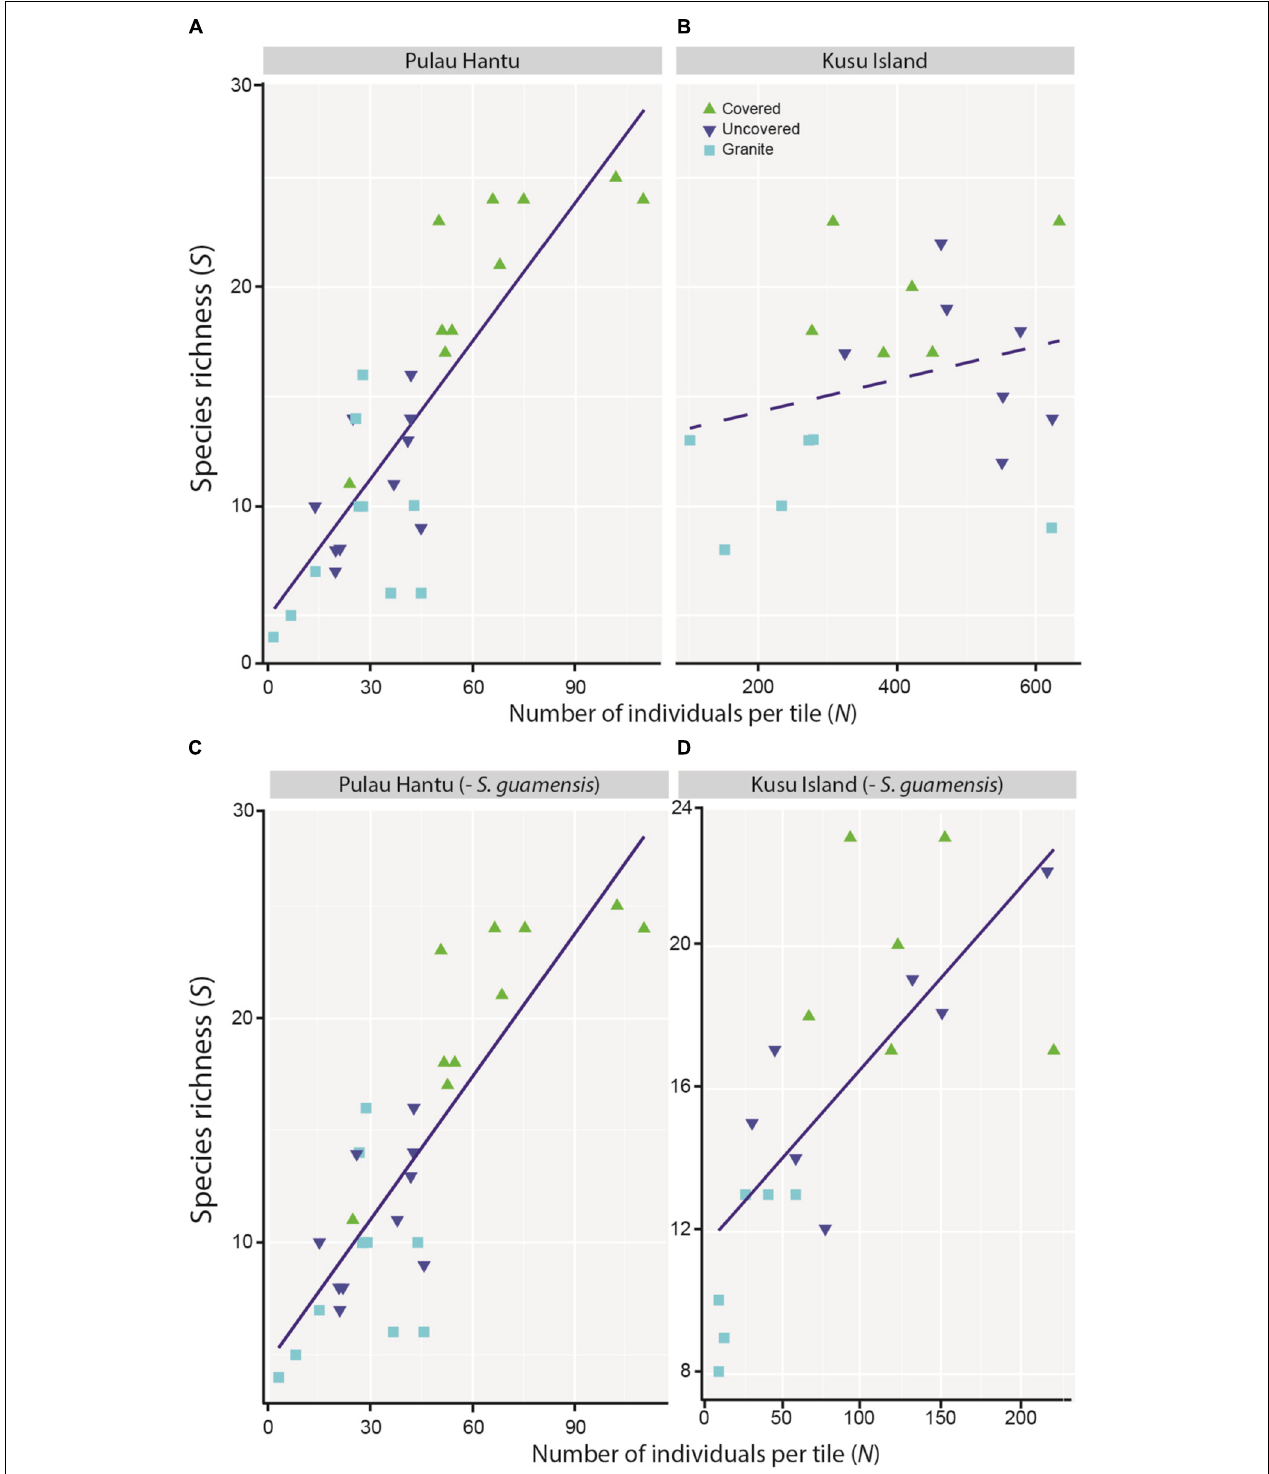
FIGURE 4 | Simple linear regression between species richness ( S ) and total number of individuals ( N ) at (A) Pulau Hantu ( r 2 = 0.68, p = 0.000), and (B) Kusu Island ( r 2 = 0.19, p = 0.262), and after removing S. guamensis at (C) Pulau Hantu ( r 2 = 0.54, p < 0.001), and (D) Kusu Island ( r 2 = 0.66, p < 0.001).